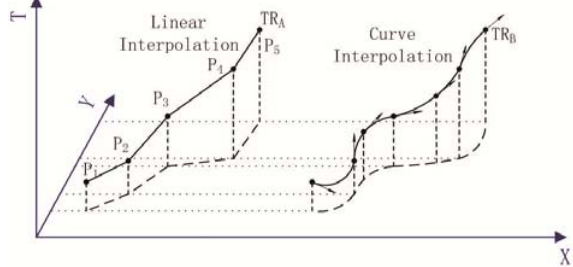
Fig. 1. Interpolation method to describe a